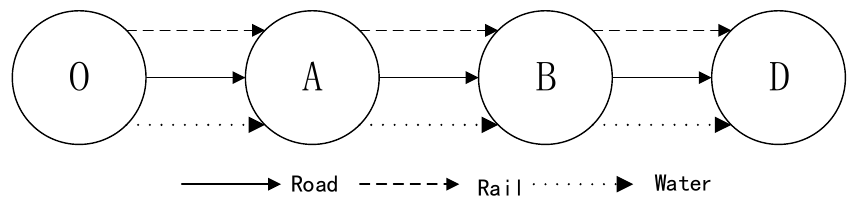
Figure 1. Diagram of multimodal transport network.